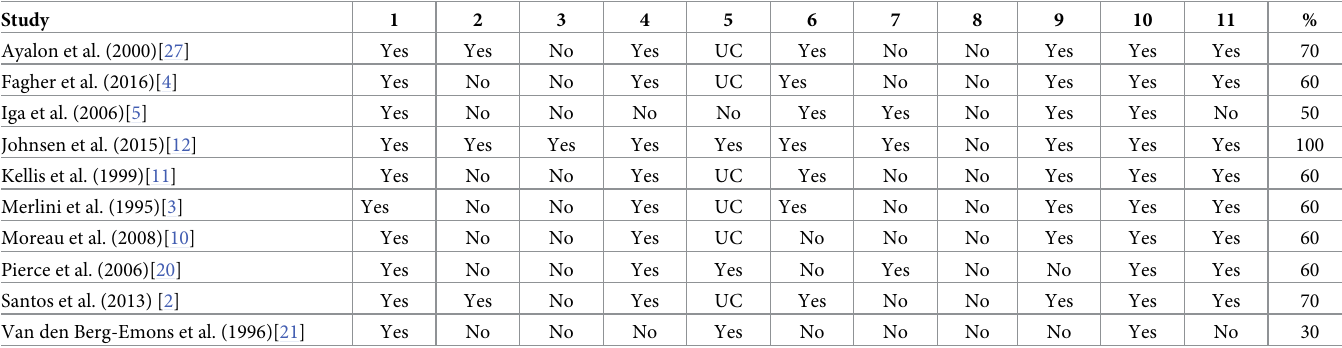
The Pierce’s study identified regular and moderate reliability where the knee flexion was assessed at 15˚/s and 90˚/s with ICCs of 0.31 and 0.38, respectively. This study also identified moderate reliability, because it measured knee extension assessed at 15˚/s and at 90˚/s with ICCs of 0.51 and 0.50, respectively. Both movements were in the concentric mode [20]. Fagher also measured knee flexion at 60˚/s and 180˚/s with ICCs of 0.62 and 0.49, respectively. This study, although it showed substantial reliability when measuring knee extension at 180˚/s with Table 2. Evaluation of the quality of the studies with Quality Appraisal of Reliability Studies (QAREL).